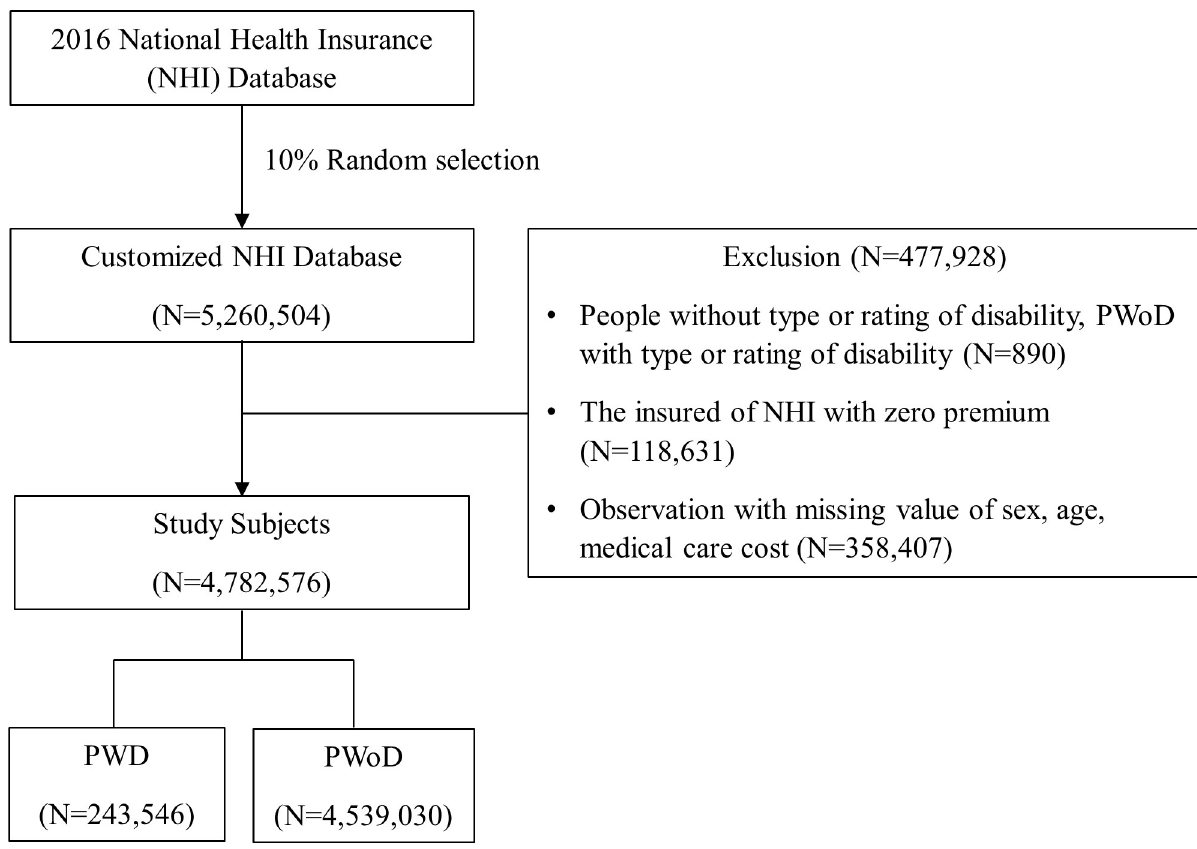
Fig 1. Study subject selection